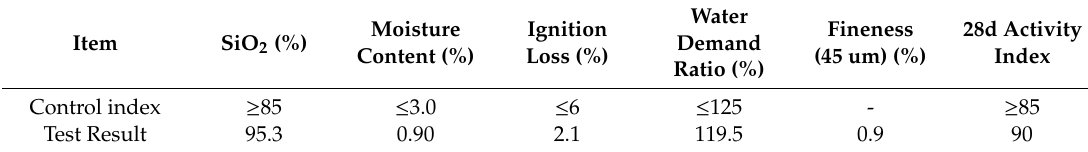
Table A2. Silicon powder performance index.